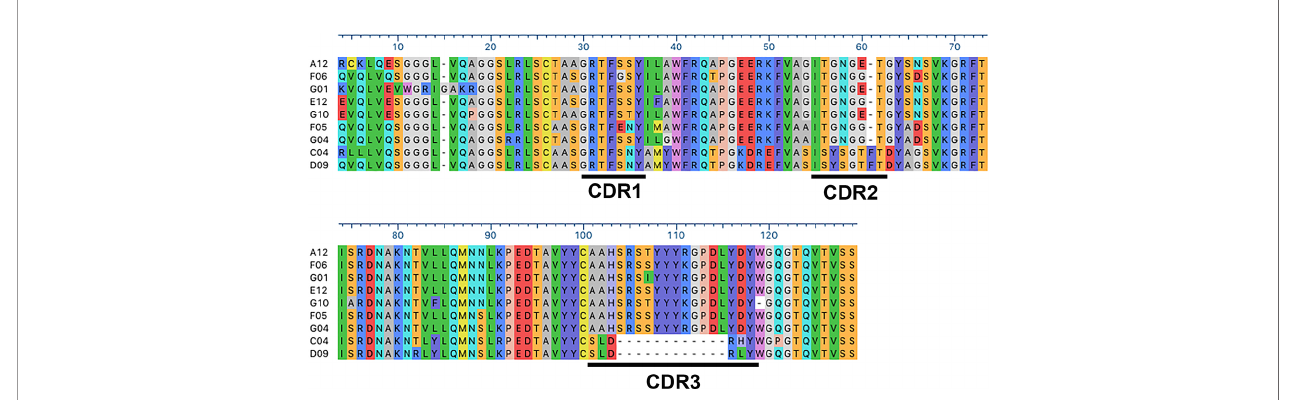
FIGURE 3 | Comparison of the predicted structures of the constructs. The three-dimensional structure of scFv62 as a monomer, its assembly as a functional trimer, and the three-dimensional (3-D) structures of scFv62-scTRAIL and VHH-D9-scTRAIL are depicted with the different moieties in different colors (blue, green and magenta for scFv62, red for VHH and light brown for TRAIL). The TRAIL trimer structure corresponds to PDB ID 1dg6 (Hymowitz et al., 2000). The structures of scFv62 and VHH-D9 have been modelled using AbodyBuilder (Leem et al., 2016). The PDB fi les can be found in Supplementary Information.